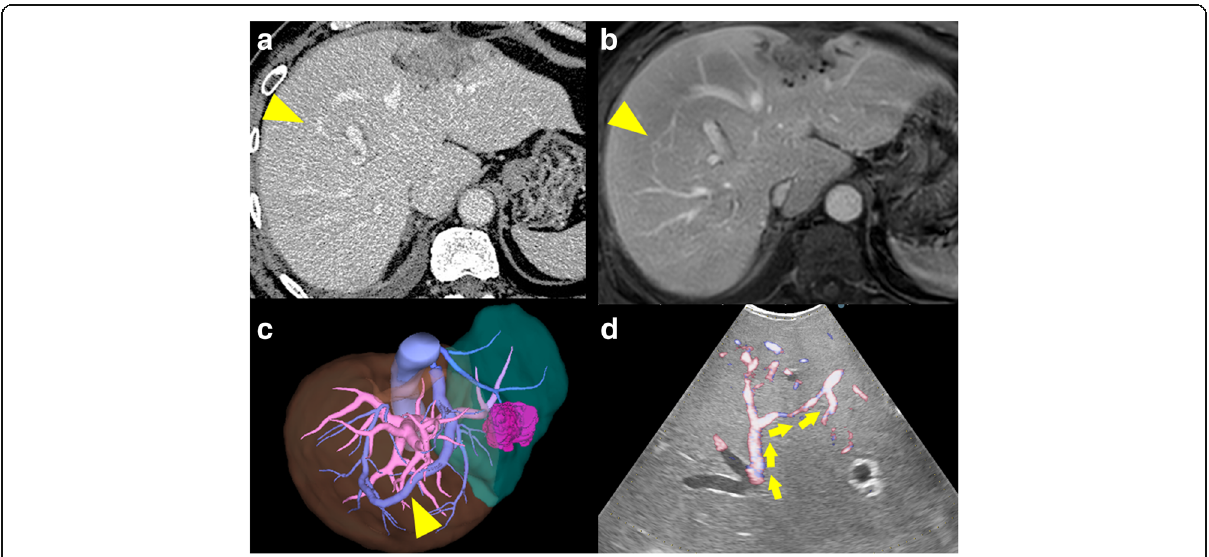
Fig. 3 Development of intrahepatic venous collaterals ( yellow arrowhead ) between RHV and MHV after the first hepatectomy. a Contrast-enhanced